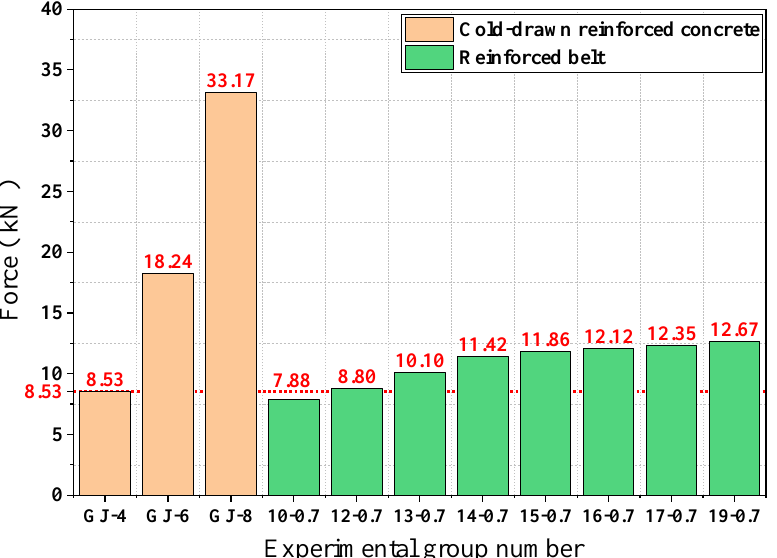
Figure 4. Comparison of peak mesh wire tension.